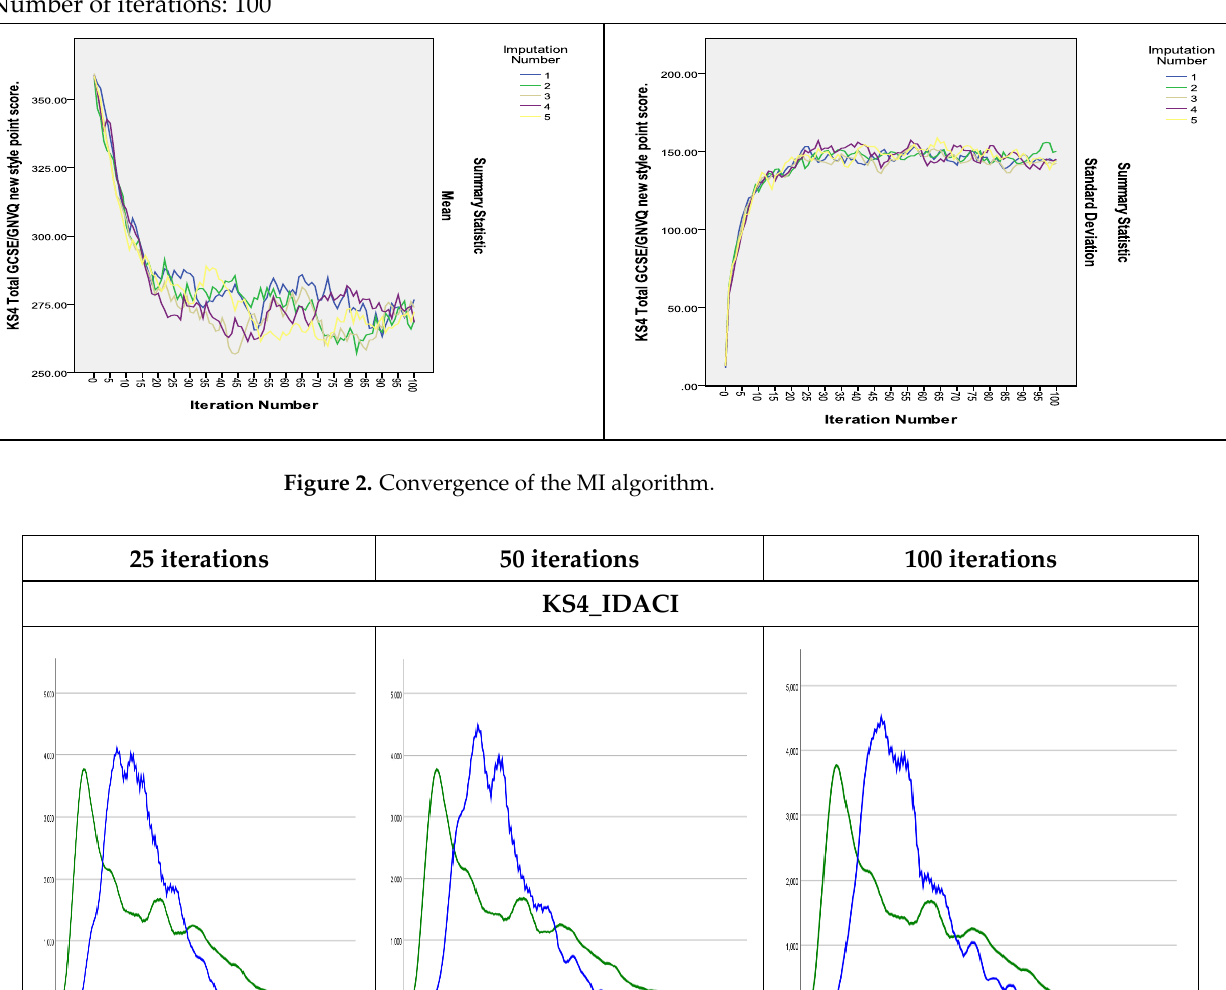
Figure 2. Convergence of the MI algorithm.